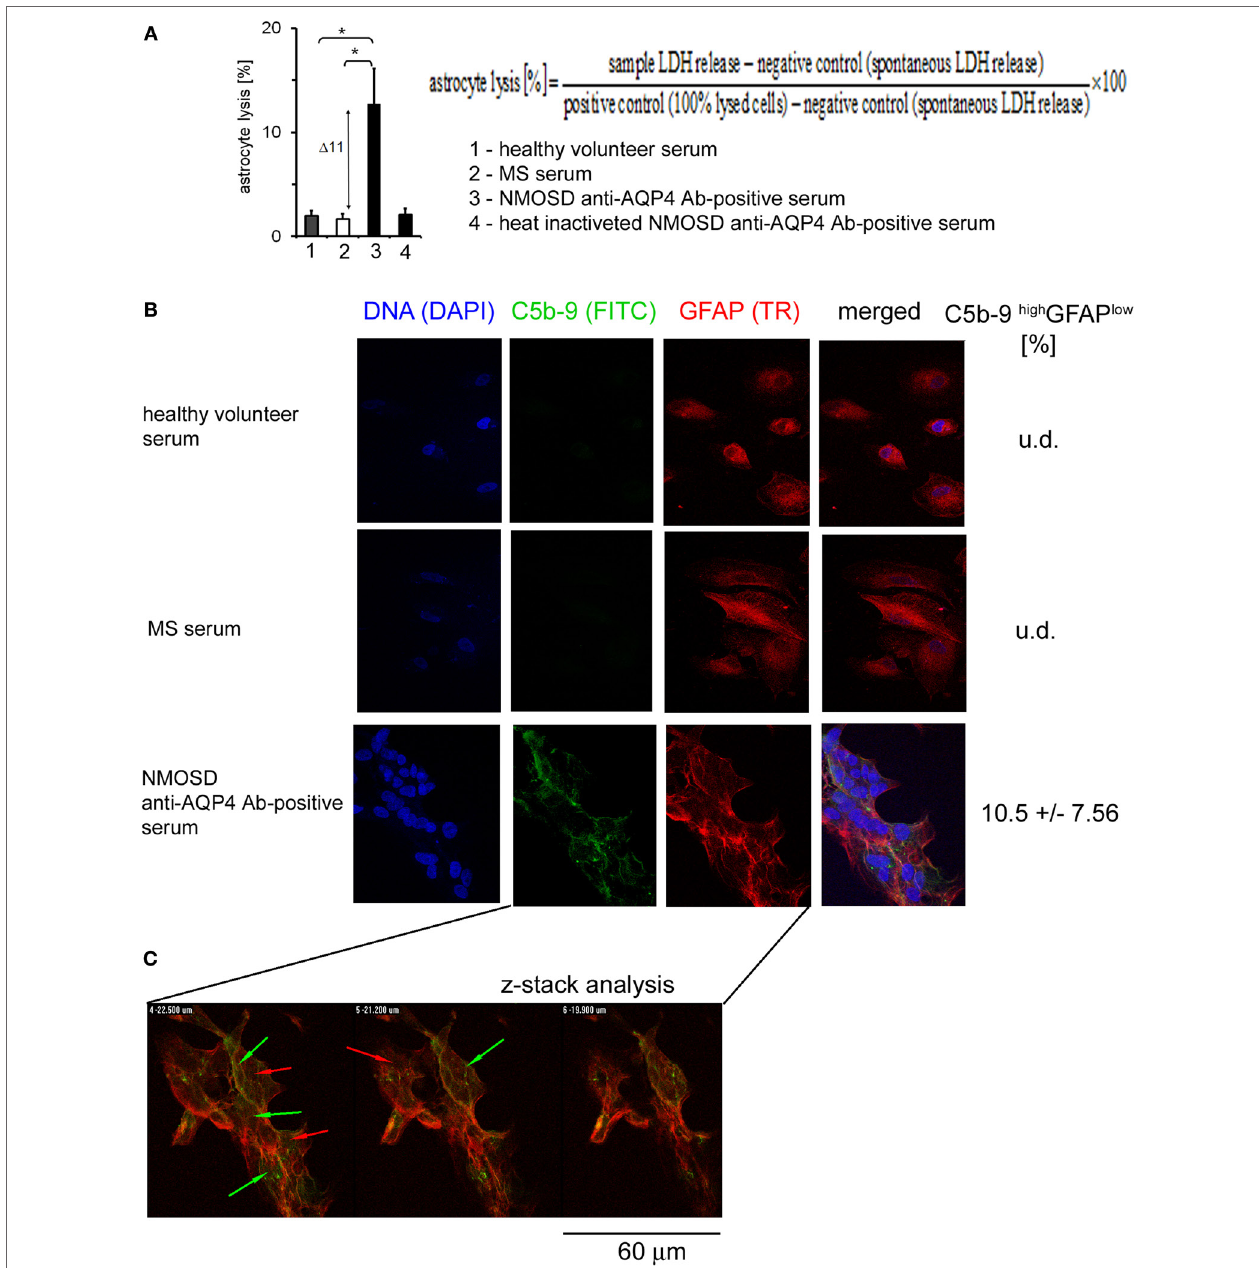
FigUre 3 | Formation of C5b-9 complexes is associated with cell lysis and glial fibrillary acidic protein (GFAP) expression loss by a little number of astrocytes. (a) 11% of astrocytes is lysed in the presence of neuromyelitis optica spectrum disorder (NMOSD) anti-aquaporin-4 (AQP4) Ab-positive serum (left panel). Cell lysis expressed as a percentage of the change of lactate dehydrogenase (LDH) concentration normalized to positive and negative controls according to formula presented in [ (a) , upper right panel]. (b) Double-staining of astrocytes with C5b-9 and GFAP. Incubation of astrocytes with anti-AQP4 Ab-positive serum from NMOSD patients, opposite to multiple sclerosis (MS) and healthy control, activates C5b-9 complex formation (green arrows) accompanied by reduced GFAP expression (red arrows). (c) Confocal microscopy analysis confirms C5b-9 complex formation on the cell surface of astrocytes which characterized GFAP low